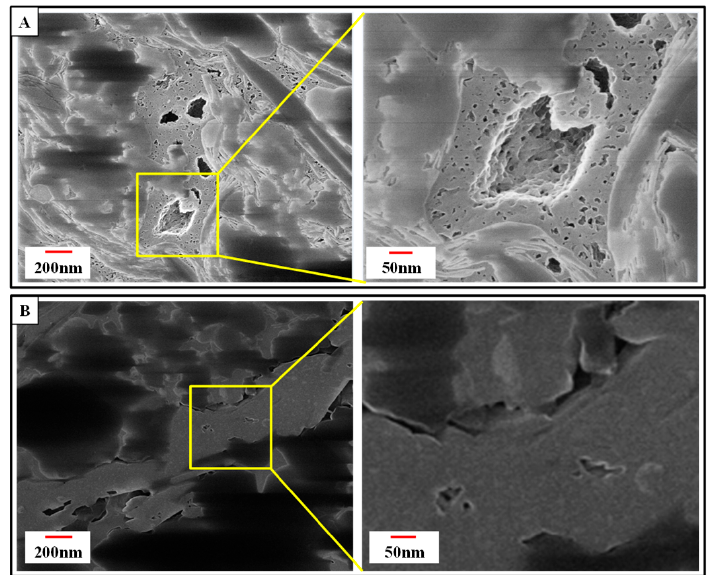
Figure 10. Focused ion beam–helium ion microscopy (FIB–HIM) images of organic-rich shale. ( A ) Organic-rich shale (total organic carbon (TOC) = 4.44%, equal-Ro = 2.58%) of the Longmaxi Formation from the Jiaoye-1 well, 2402 m.; ( B ) organic-rich shale (TOC = 5.78%, equal-Ro = 3.47%) in the